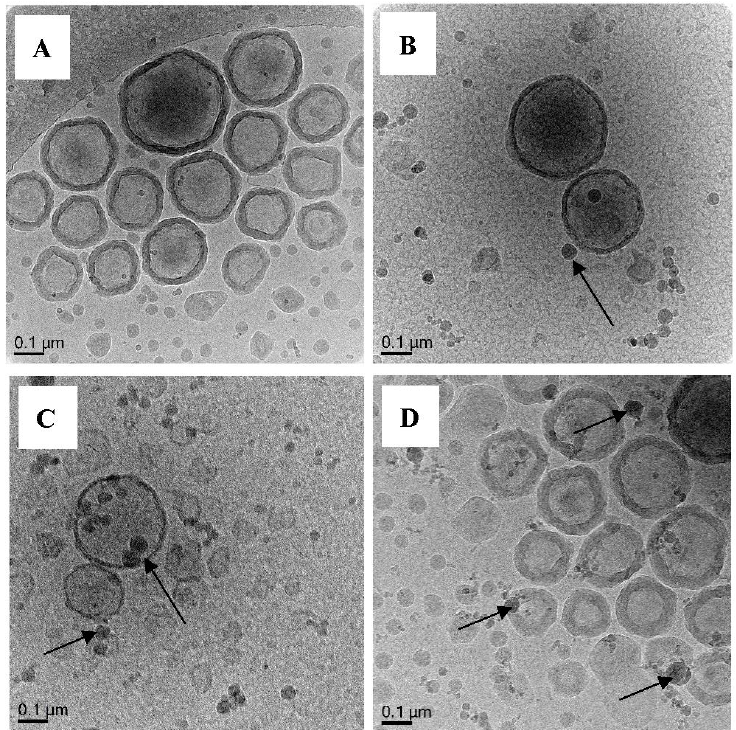
Figure 13. Cryo-TEM micrographs of Exp 9 ( A ), Exp 10 ( B ), Exp 11 ( C ) and Exp 12 ( D ). Polymerization of (DODAB- Oligo1 ) with varying amount MA/EGDA. Some intense darks solids are crystalline ice particles (marked with arrows) introduced by contamination during sample vitrification. Additional images in Figure S8 (Exp 9) and Figure S9 (Exp 12).